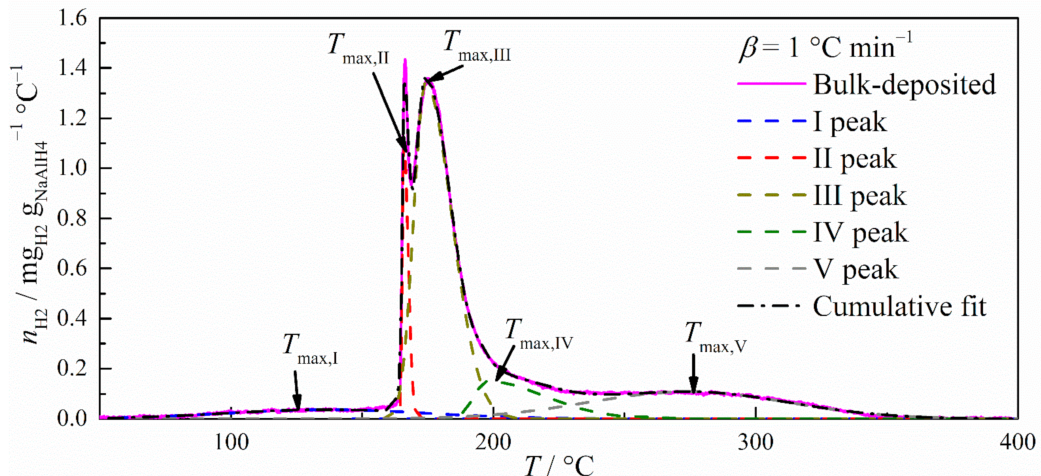
Figure 2. Hydrogen release curve from bulk-deposited measured during temperature ramp rate, β , of 1 ◦ C min − 1 with the corresponding hydrogen release peak fits.